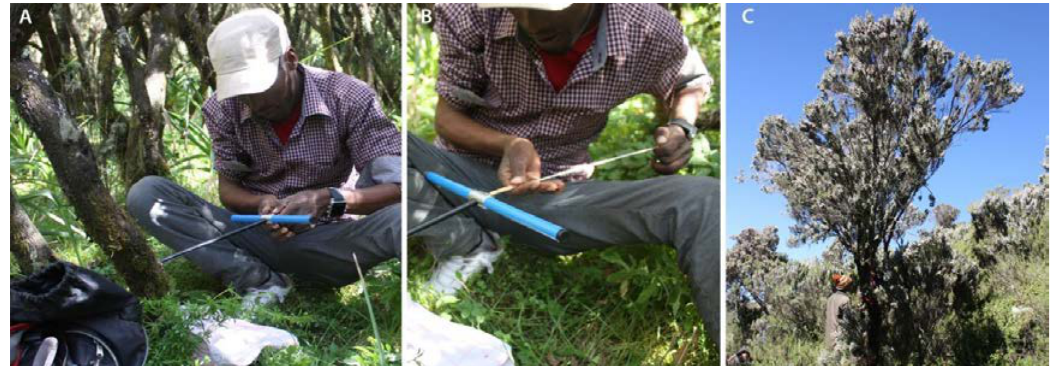
Figure 3. Wood sample collection using an increment borer in Lib Amba Mountain: ( A , B ) tree coring and core extraction; ( C ) Erica arborea tree at Lib Amba Mountain.